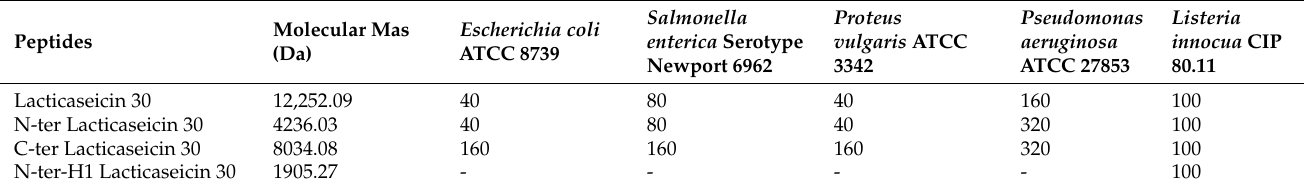
Table 1. Minimum inhibitory concentrations (MIC) values ( µ g/mL) of lacticaseicin 30 and its trun- cated forms.